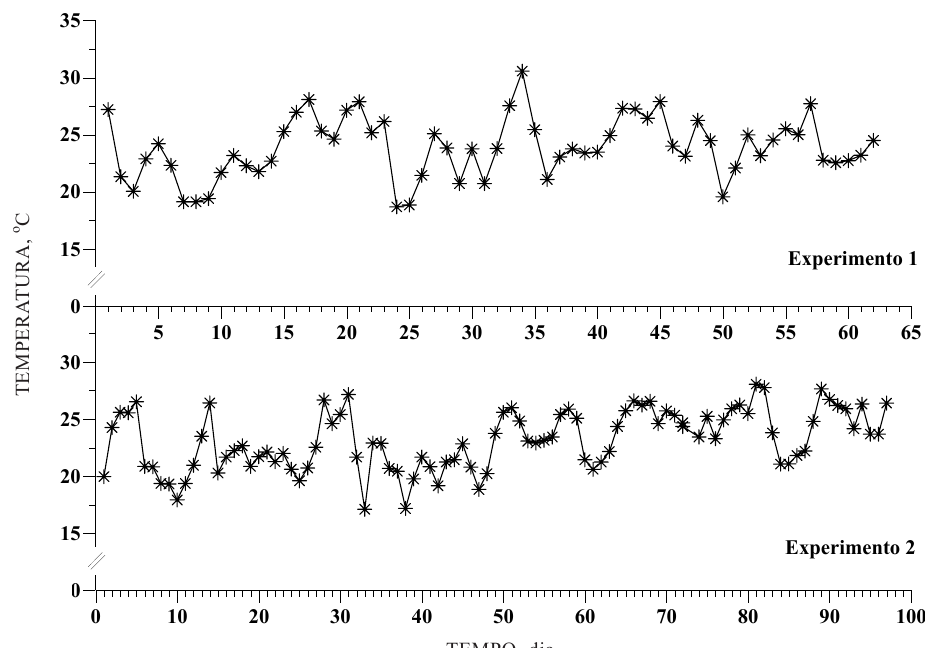
Figura 1. Temperatura média do ar durante os experimentos 1 e